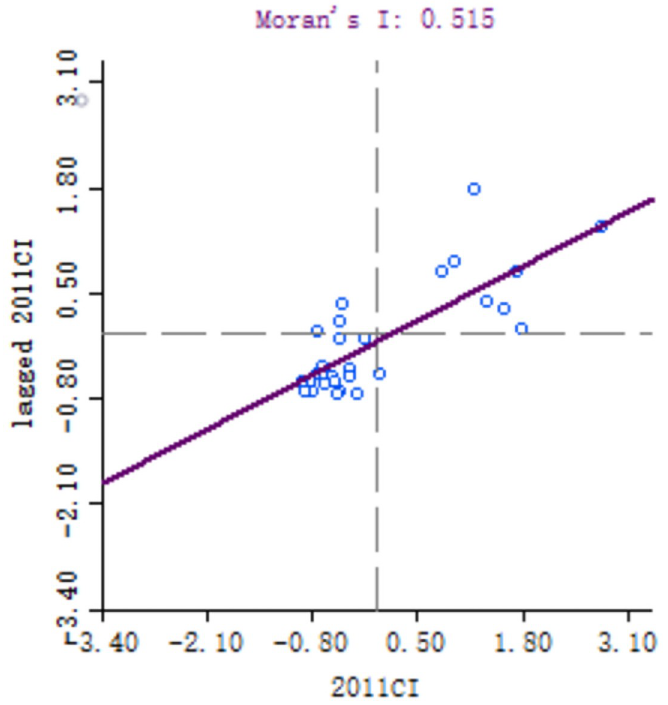
Fig 6. Moran scatter chart of industrial high quality development level in 2011.